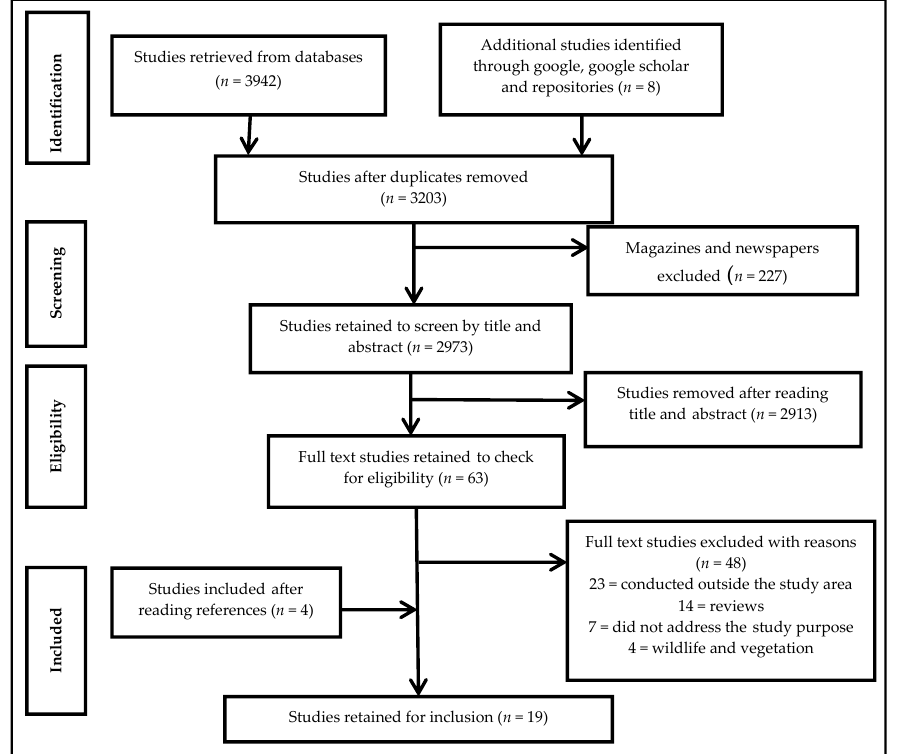
Figure 1. The Preferred Reporting Items for Systematic Reviews and Meta-Analyses (PRISMA) flow diagram.